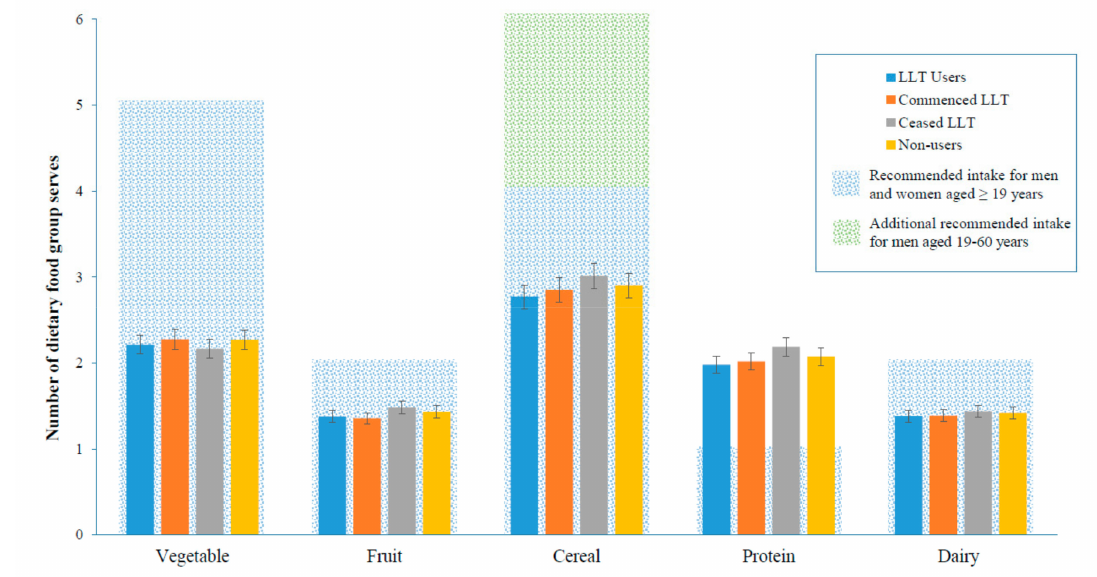
Figure 2. Adjusted total serves per day at the follow up of key food groups at the 50th quantile, by LLT (Lipid-lowering therapy) status, median (95% CI). Adjusted for age, gender, body mass index (kg / m 2 ), smoking status, exercise status, education status, diabetes status, prior cardiovascular disease, hypertension, and baseline dietary serves per day. Lipid-lowering therapy